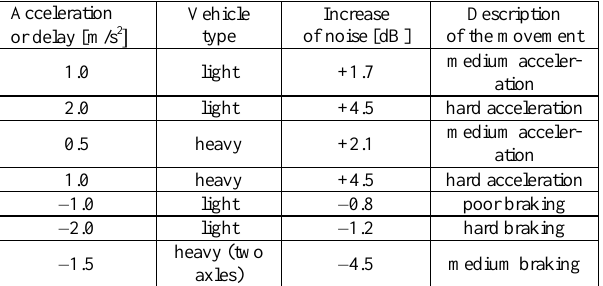
Table 2. Influence of delayed and accelerated motion on road noise [3] Acceleration Vehicle or delay [m/s 2 ]